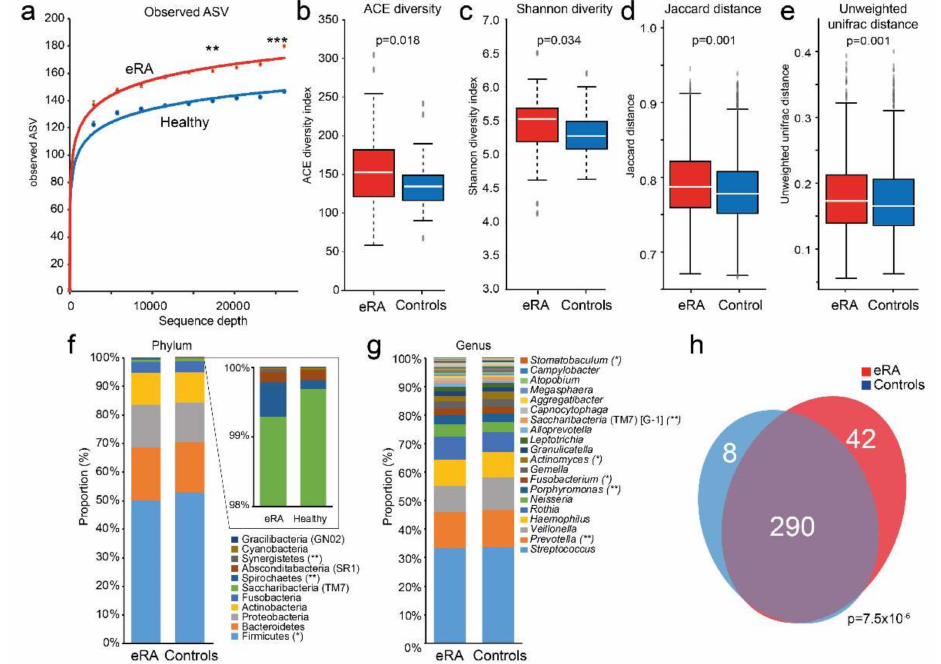
Figure 1. Comparison of saliva microbiota diversity, (dis)similarity, evenness and shared species between early onset RA and healthy subjects. ( a ) Rarefaction curves for amplicon sequence variants (ASV) in early onset RA (eRA) and healthy control subjects. Box plots of ( b ) ACE diversity, ( c ) Shan- non diversity, ( d ) Jaccard distance and ( e ) unweighted unifrac distance. Stacked bar graph of top 20 ( f ) phyla and ( g ) genera for eRA patients and healthy control subjects. ***, ** and * indicate <0.001, <0.01 and <0.05, respectively. ( h ) Venn diagram illustrating overlapping and unique species in e RA and healthy controls. A full list of detected phyla, classes, orders, families, genera and species are presented in Table